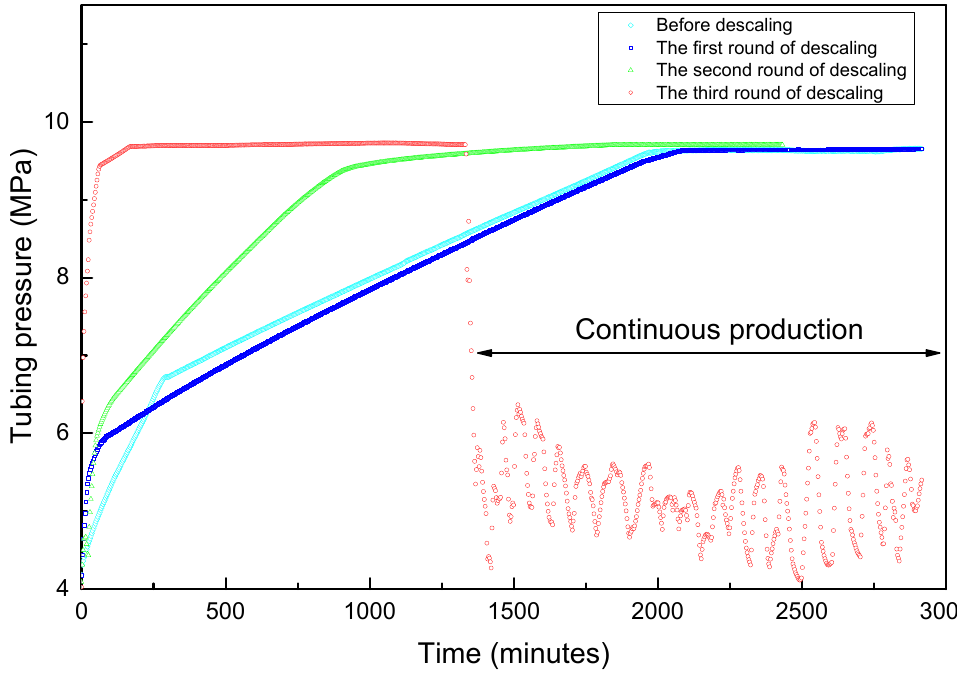
Figure 10. The real-time shut-in and production tubing pressure changes before and after descaling.